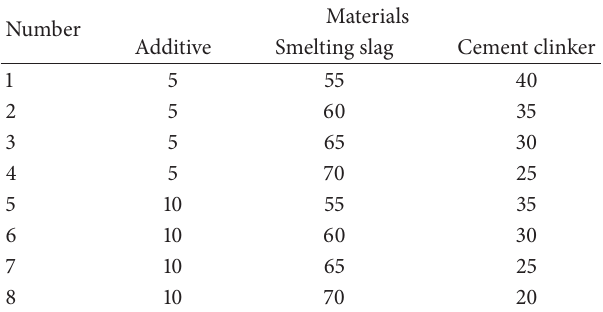
Table 2: The ratio of materials for smelting slag